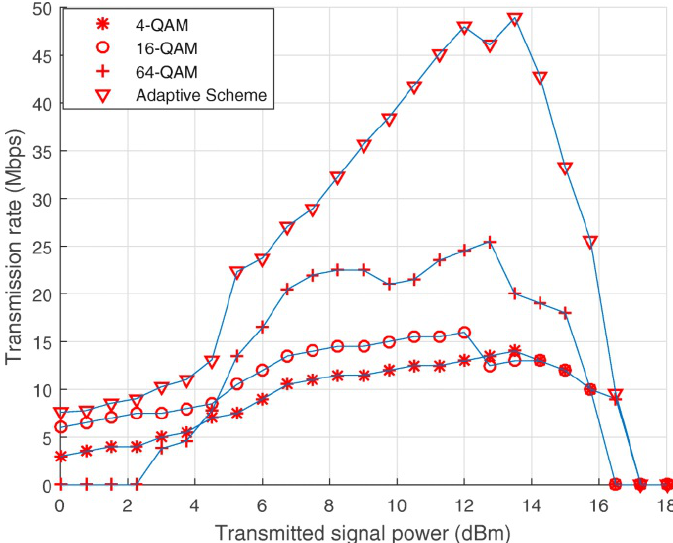
Fig. 5 FRFT and FFT reduce the PAPR comparison chart based on the limiting algorithm. FFT, fast Fourier transform; FRFT, fractional Fourier